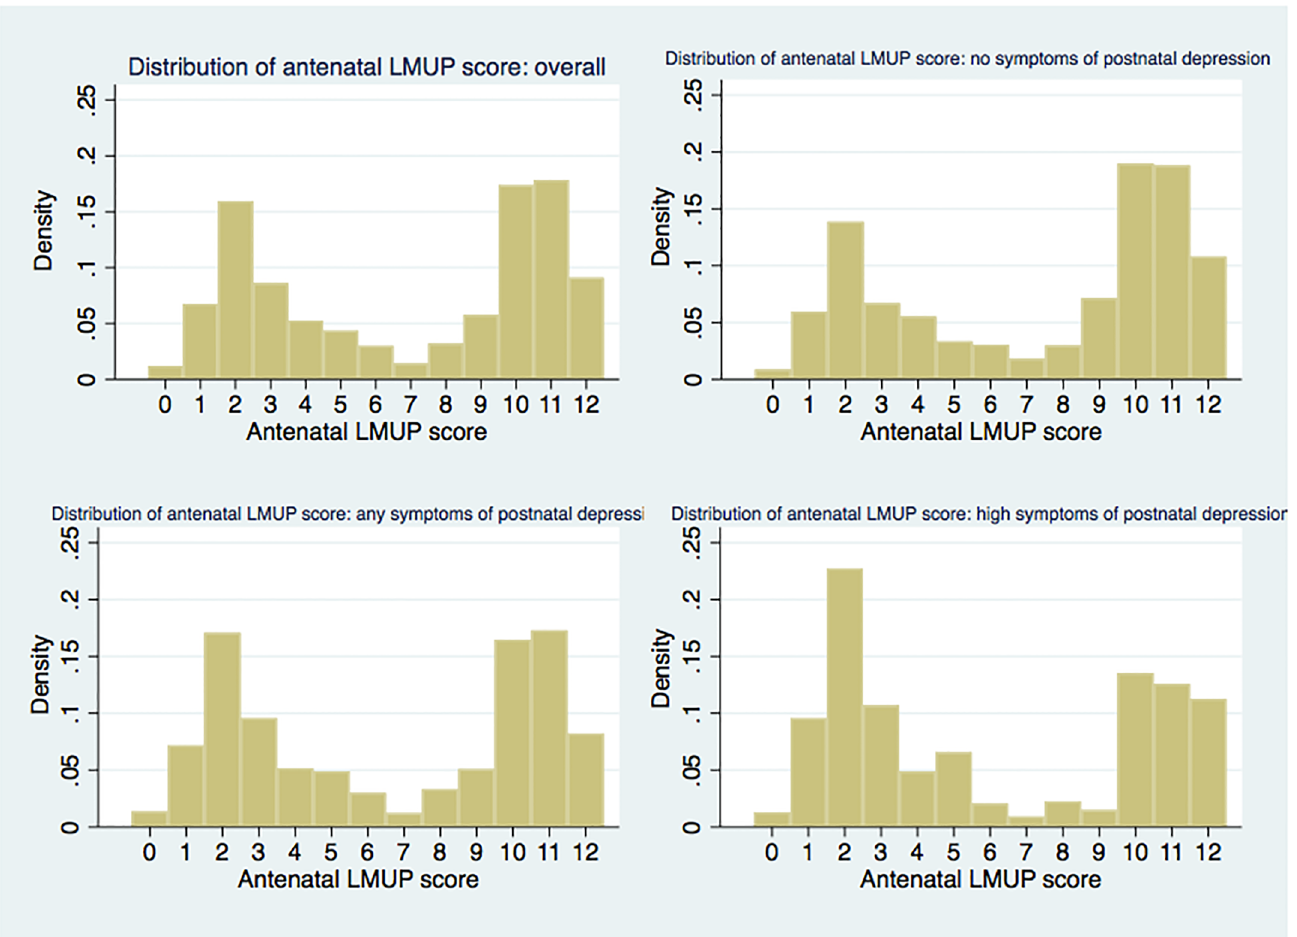
Fig 2. Distribution of antenatal LMUP score overall and by level of maternal postnatal depression symptoms.